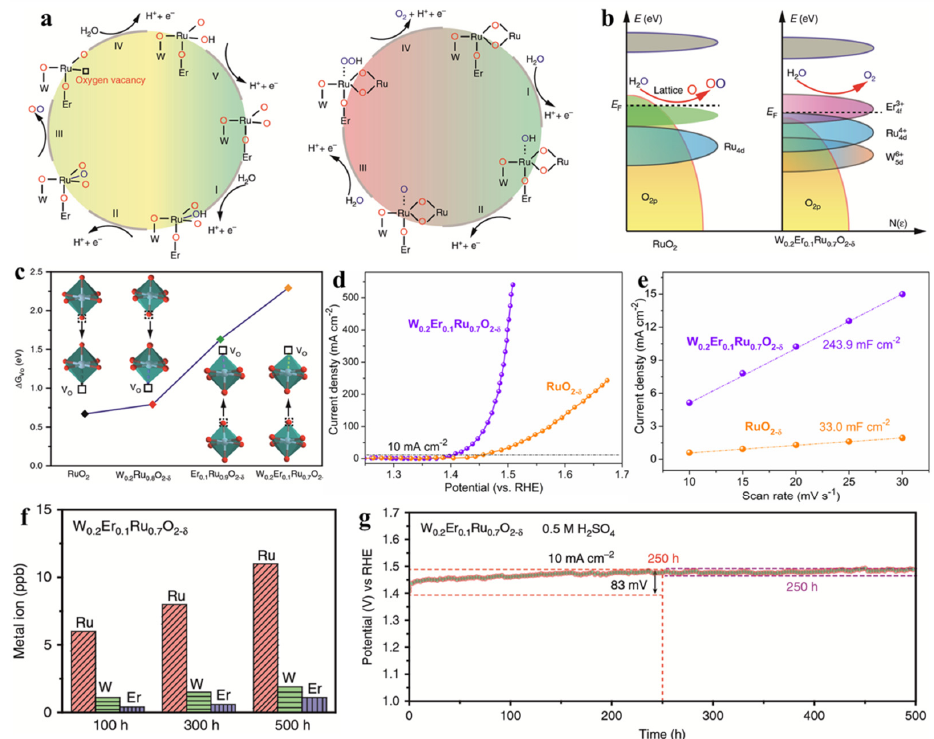
Figure 3. ( a ) OER reaction mechanisms of LOM and AEM for RuO 2 in acidic media. ( b ) Schematic diagrams of the band model for RuO 2 and co-doped RuO 2 for the OER in acidic media. ( c ) Calculated oxygen vacancy formation energy at different positions of RuO 2 , single-doped RuO 2 , and co-doped RuO 2 . ( d ) LSV curves of RuO 2 and co-doped RuO 2 for the OER in a 0.5 M H 2 SO 4 solution. ( e ) Linear fitting of the capacitive current densities vs. CV scan rates for RuO 2 and co-doped RuO 2 . ( f ) Metal ion dissolution during the OER process. ( g ) Stability tests for the co-doped RuO 2 catalyst. Reproduced with permission. [102] Copyright 2020, Nature Publishing Group.